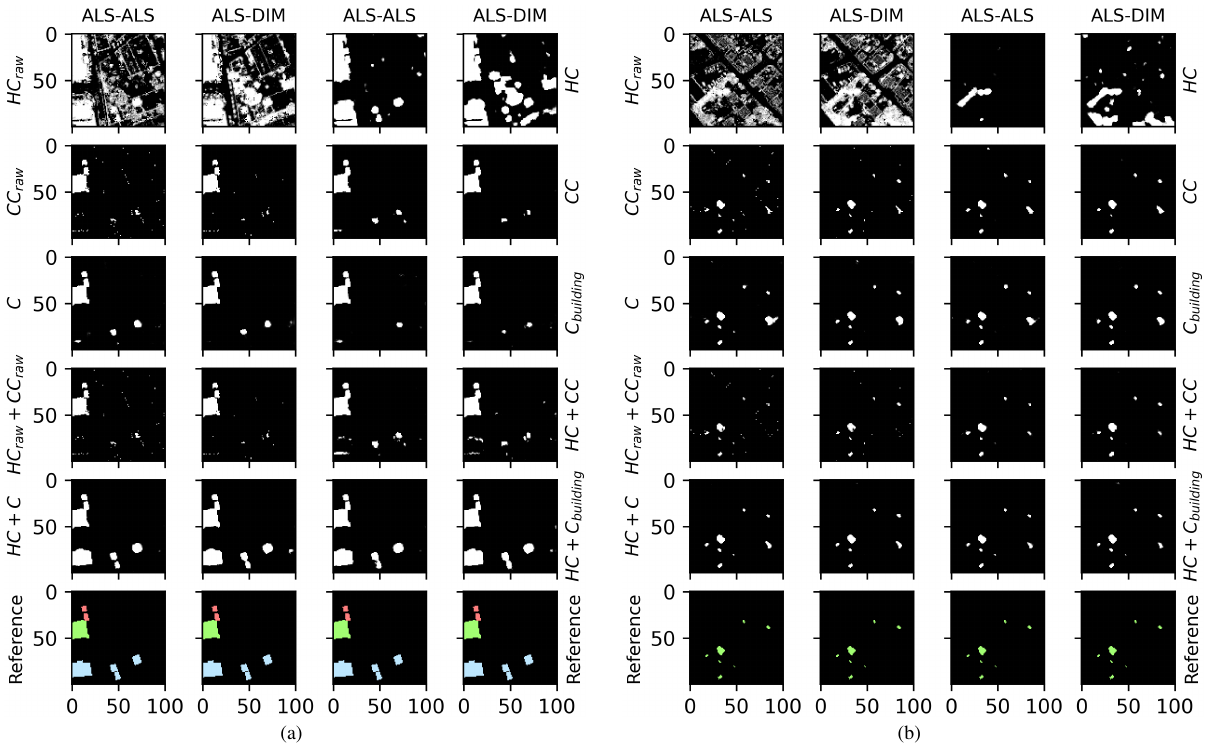
Figure 5. Predicted change detection results for two test images. While the top five rows show the detections for ALS-ALS and ALS-DIM for two examined input variants each, the bottom row displays the reference coloured by their respective change class: new in green, demolished in red and construction in